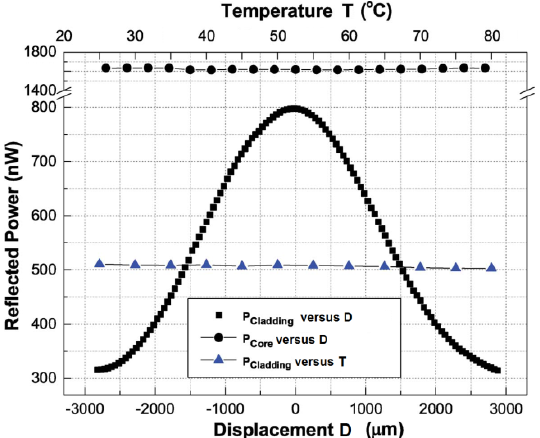
Figure 3. Cascade of up-taper and fiber Bragg grating (FBG) [54]. Behavior of cladding mode and core mode power versus displacement and cladding mode power versus